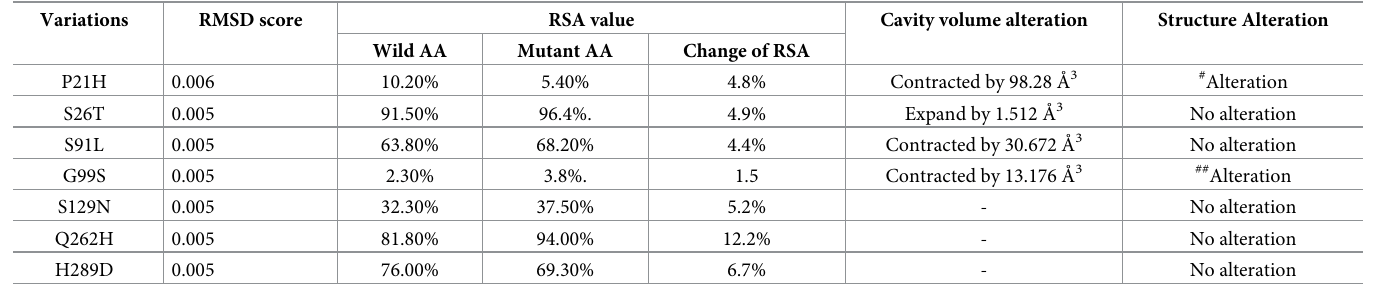
Table 6. Structure analyses of mutated amino acids in GATA1 protein using Pymol and Missense3D.